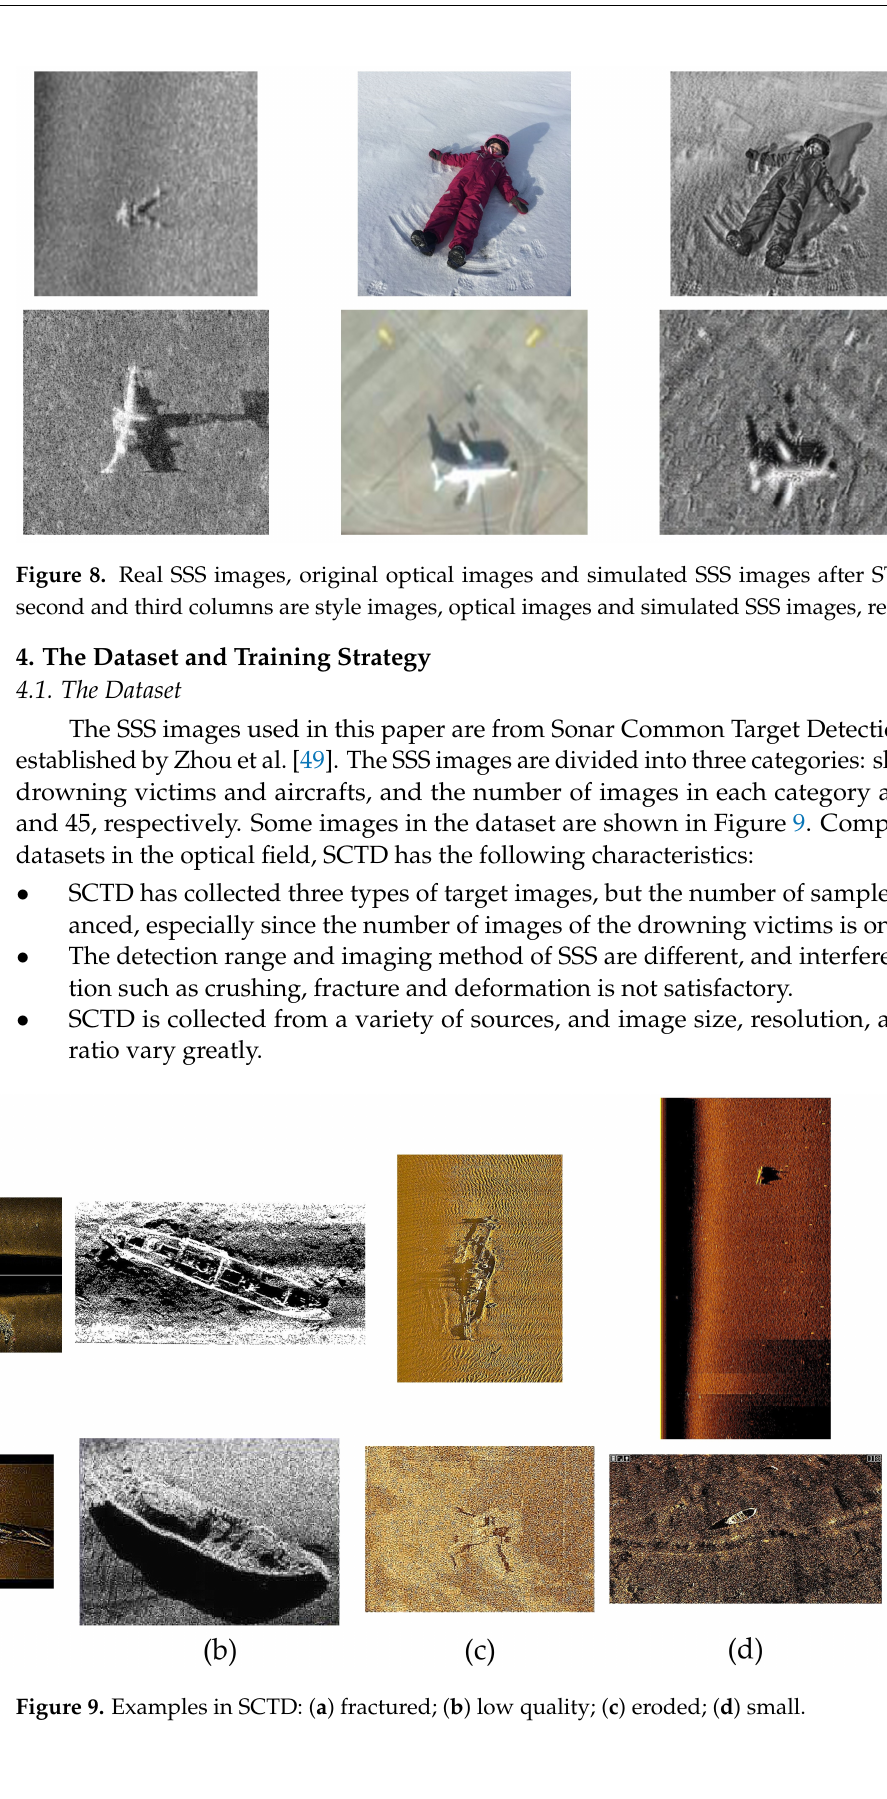
Figure 9. Examples in SCTD: ( a ) fractured; ( b ) low quality; ( c ) eroded; ( d ) small. Table 1 gives the details of HSCTD. Among the shuffled images, 20% is selected to form a test set to perform cross-validation. Considering that the division of data sets will affect the training effect, it randomly adopts dividing data sets and carries out five re- peated experiments. The average value of five experiments is taken as the result of train- ing for analysis.